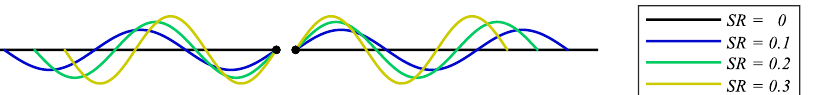
Figure 2. Sample design of an antenna with 𝑛 = 3 for different values of 𝑆𝑅 . It is evident that the more the 𝑆𝑅 increases, the higher the width of the antenna.